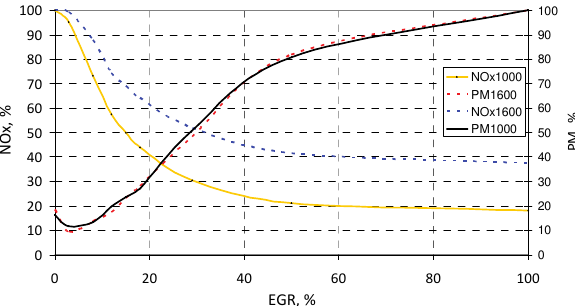
Fig. 18. Impact of EGR opening level at relative NO x and PM concentra- tion at 190 Nm